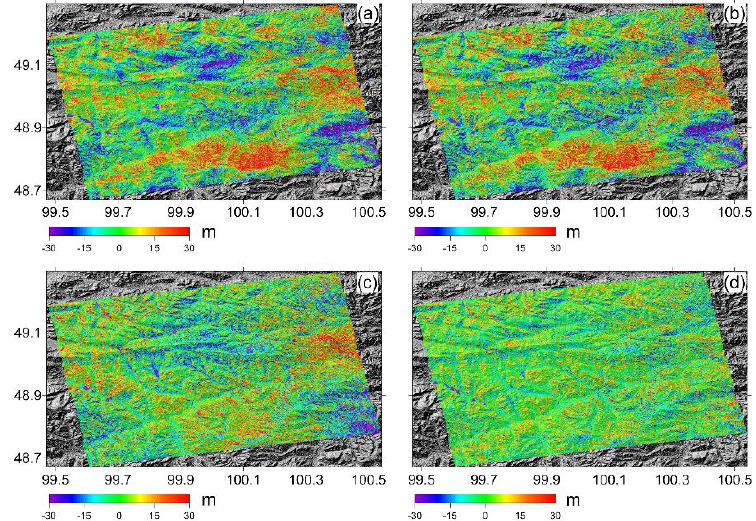
Figure 19. The elevation difference maps between InSAR DEMs and SRTM DEM. ( a – d ) indicates the wavelet decomposition scale with 3, 6, 9 and 11 (the selection of this paper), respectively.